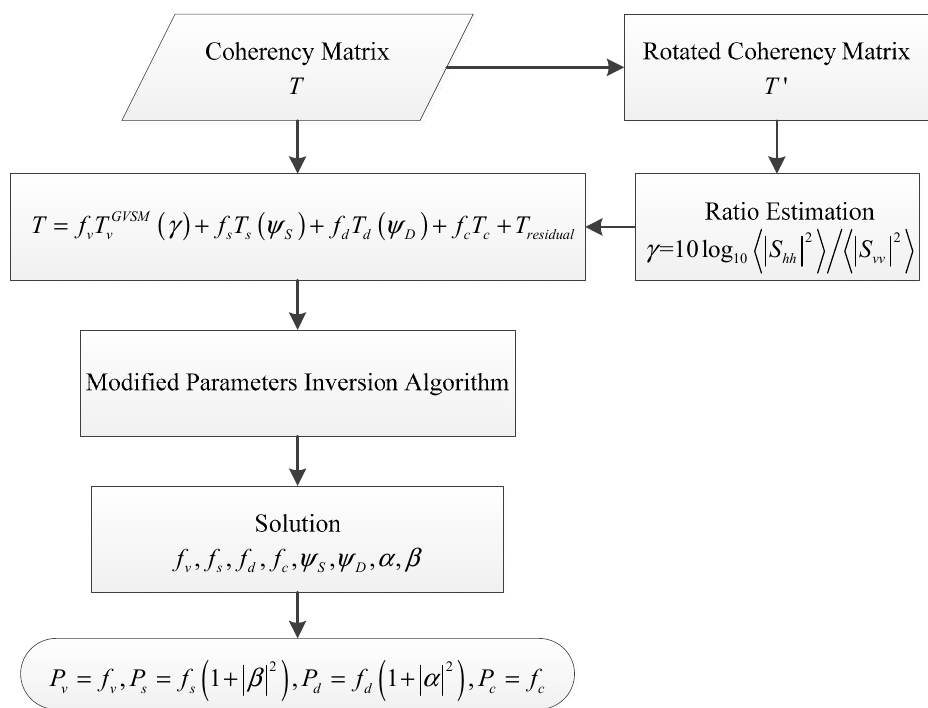
Figure 4. Flowchart of general model-based decomposition with the generalized volume scattering model (GVSM).